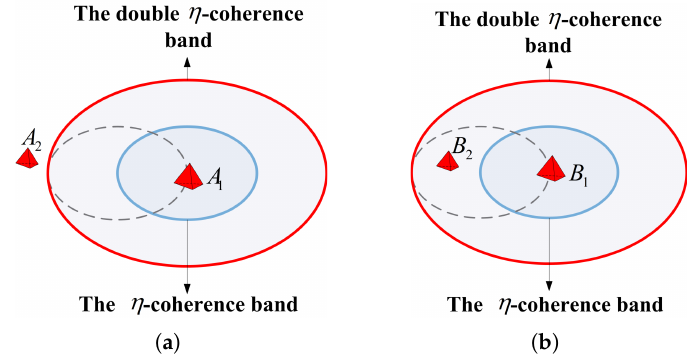
Figure 5. Coherence band and the scatterers. ( a ) the scatterer A 2 is outside the double η -coherence band of A 1 ; ( b ) the scatterer B 2 is in the double η -coherence band of B 1